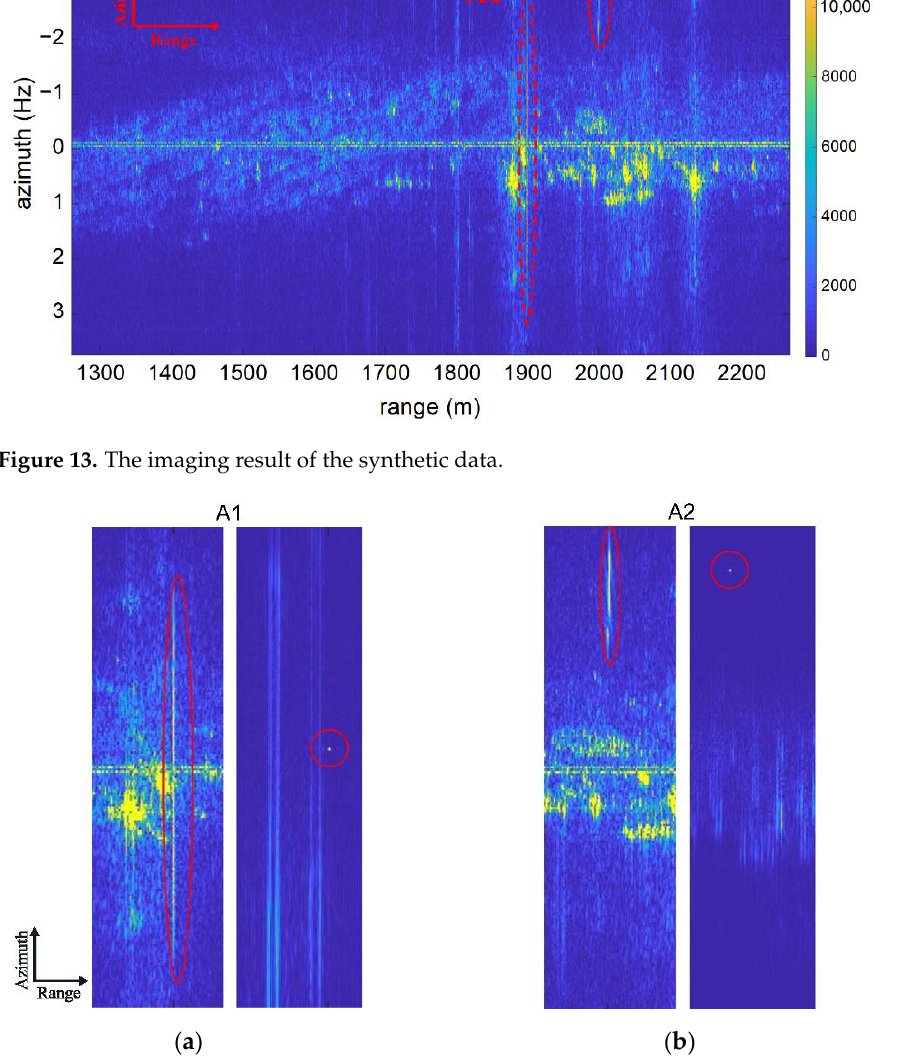
Figure 14. Comparison of imaging results of two ground moving targets before and after refocusing. ( a ) Imaging results of A1 before and after refocusing. ( b ) Imaging results of A2 before and after refocusing.